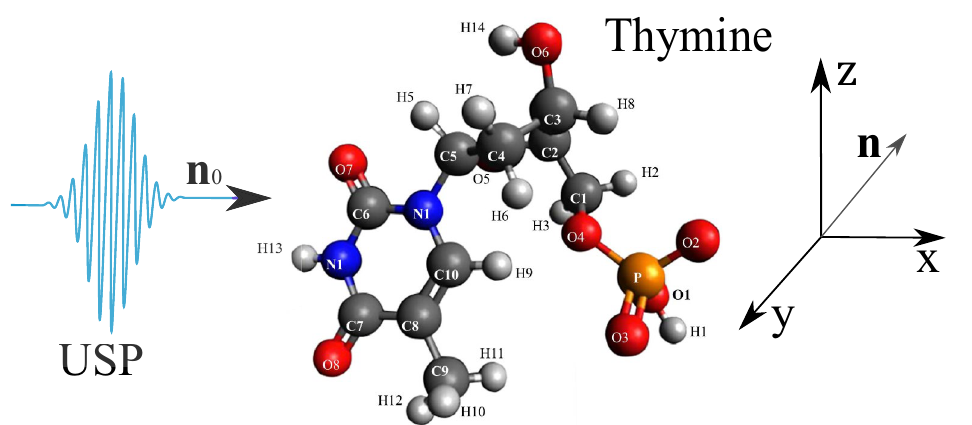
Figure 6. The thymine on which the USP falls is represented, as well as the chosen coordinate system. The calculation was performed in the spatial orientation of the thymine in relation to the USP in the chosen coordinate system shown in this